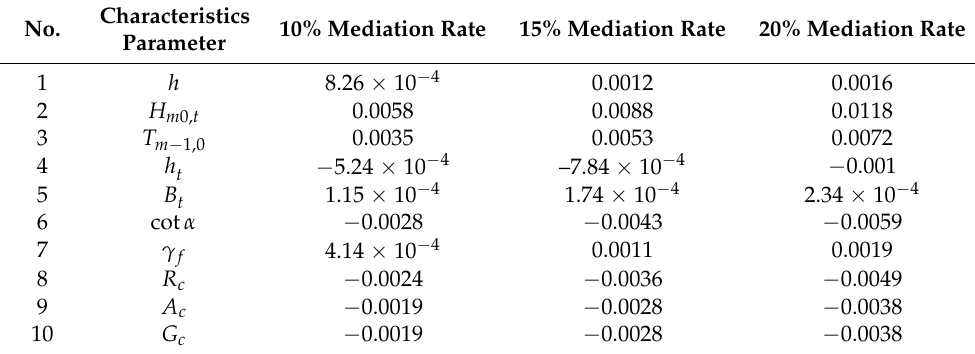
Figure 13. Curve of the MIV value changes in overtopping influence factors. Table 4. MIV values of input characteristic parameters under different mediation